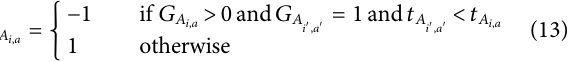
TABLE 2 | The value of the constraint of thetask accomplishment for each action: making the task progress ( G A making the task regress ( G A